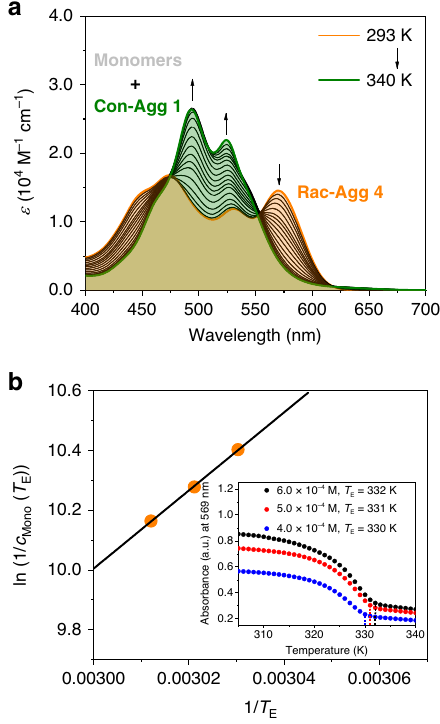
Fig. 5 Thermodynamic analysis of Rac-Agg 4. a Temperature-dependent UV/vis absorption spectra of Rac-Agg 4 upon heating ( c T = 4.0 × 10 − 4 M, T = 293 K → 340 K, heating rate: 1 K min − 1 ). b Van ’ t Hoff analysis of the thermodynamic parameters of the elongation of Rac-Agg 4 . Inset: Plot of the absorbances at λ = 569 nm as a function of temperature and concentration. The dotted lines indicate the respective elongation